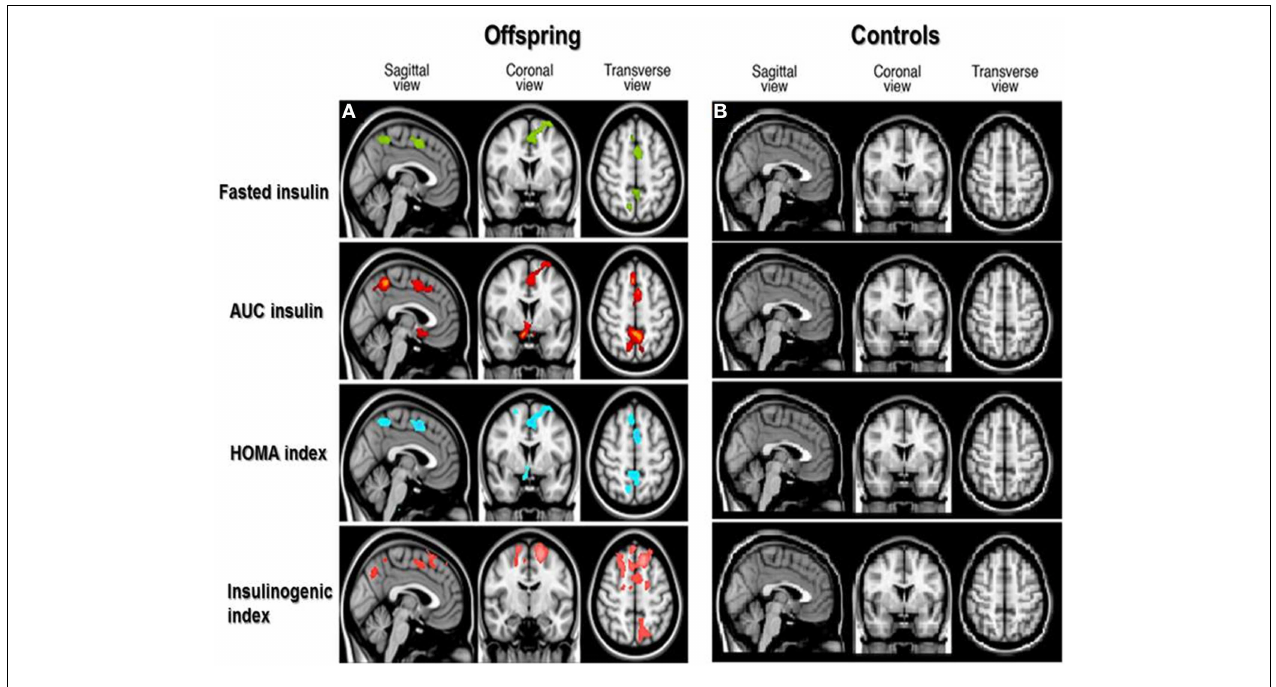
MTR and OGTT derived insulin parameters, with the different colors indicating significant associations as follows: fasted insulin in green, insulin Area Under the Curve (AUC) in red, Homeostatic Model Assessment (HOMA index) of insulin resistance in blue, and insulinogenic index in pink. No colored areas are seen in the controls, because the associations were not significant in the